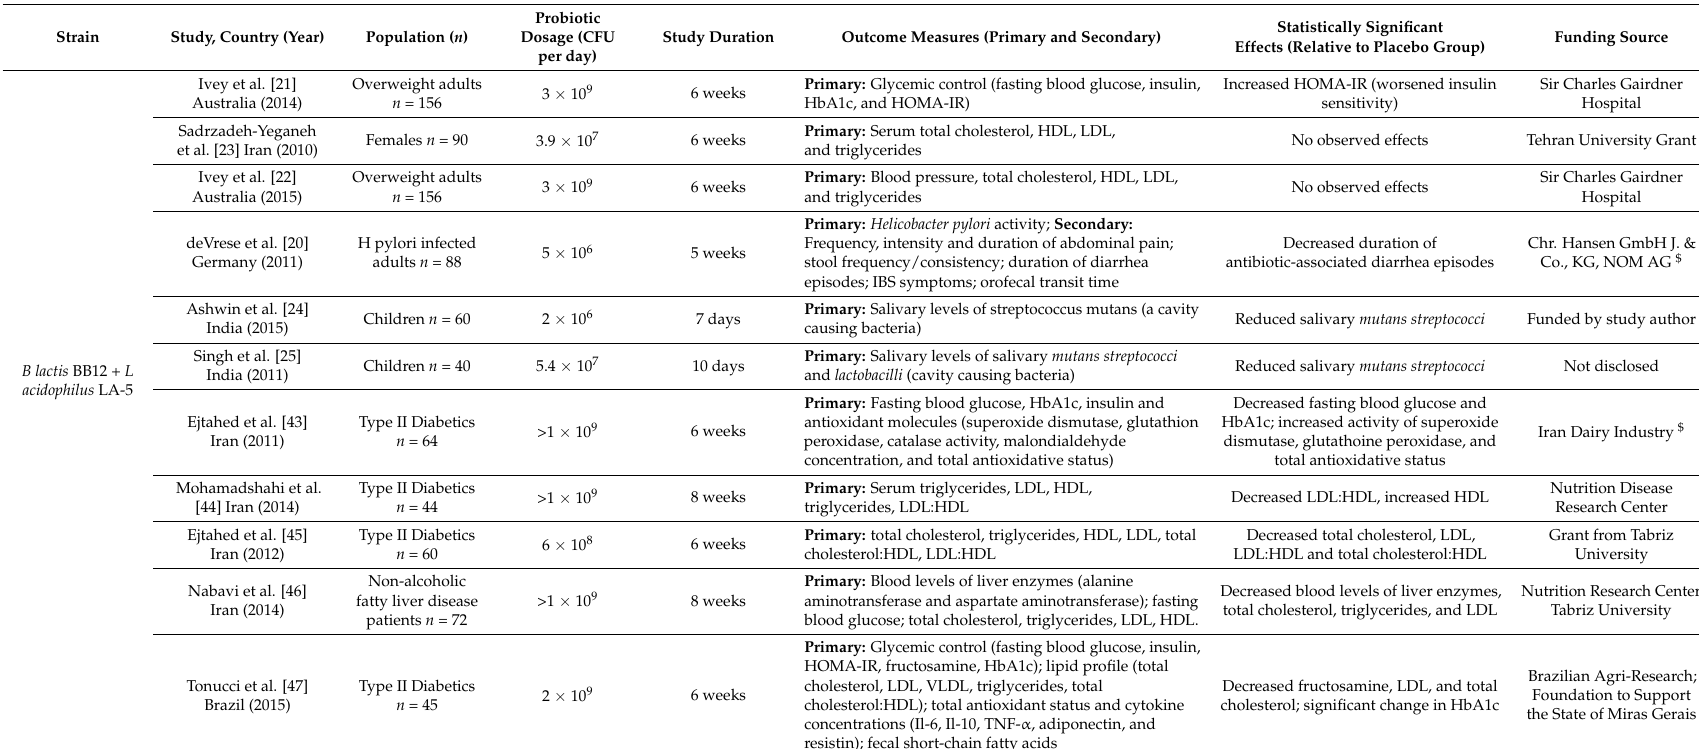
Table 2. Results of the review of randomized controlled trials investigating the health effects of probiotic strains found in the Canadian food supply 1 . Probiotic Strain Study, Country (Year) Population ( n ) Dosage (CFU Study Duration Outcome Measures (Primary and Secondary) Statistically Significant Effects (Relative to Placebo